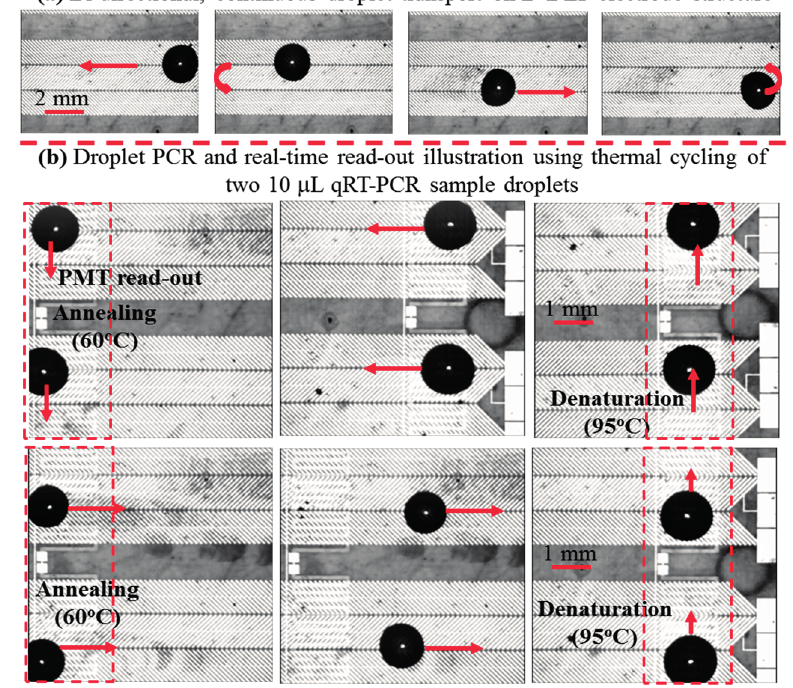
Figure 3. Photomicrographs of ( a ) the different phases of continuous droplet transport over the newly designed bi-directional electrode scheme and ( b ) frames extracted from a real-time video showing different stages during qRT-PCR thermal cycling using two 10 μ L polymerase chain reaction (PCR) droplets on a segment of the